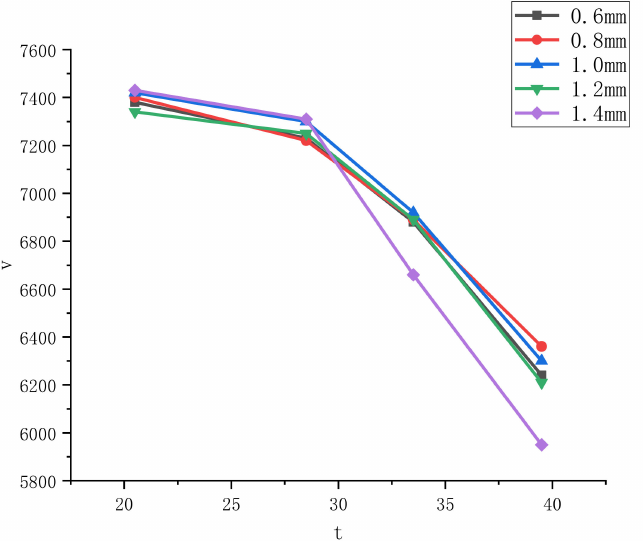
Figure 6. Jet velocity under different grid